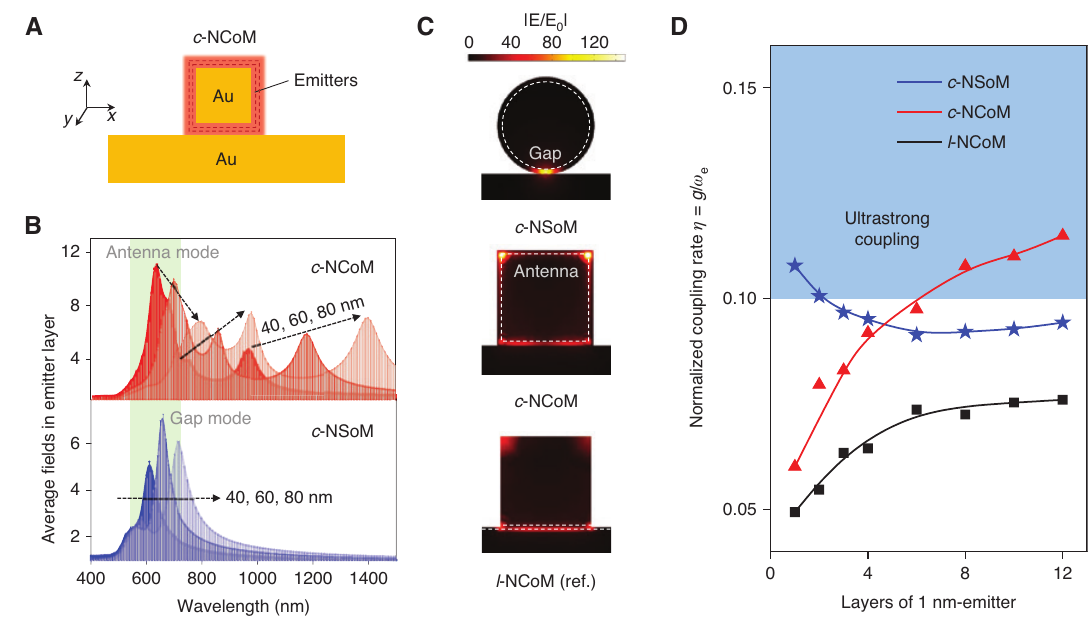
Figure 1: Ultrastrong coupling in c -NCoM. (A) Schematics of c -NCoM. (B) Optical modes in c -NCoM and c -NSoM configurations for nanoparticle sizes of 40, 60, and 80 nm (indicated by the direction of arrows) and an emitter thickness of 2 nm. The green block represents the interested wavelength range of the coated emitters, which are coupled to the antenna mode of c -NCoM and the gap mode of c -NSoM, respectively. (C) Near-field distributions of the optical modes coupled to the studied emitters in three different configurations: c -NSoM, c -NCoM, and l -NCoM. The nanoparticles have the same size of 40 nm with 2-nm-thick emitter coating. (D) Simulated normalized coupling rate η as a function of the number of emitter layers (where each emitter layer is assumed to be 1 nm thick) in the three configurations in (C). The blue-shaded area with η > 0.1 defines the ultrastrong coupling